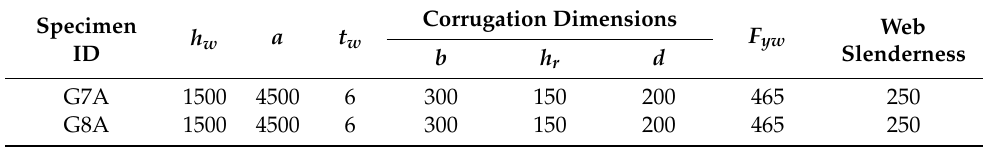
Table A5. Data of specimens tested by Driver et al. [5].